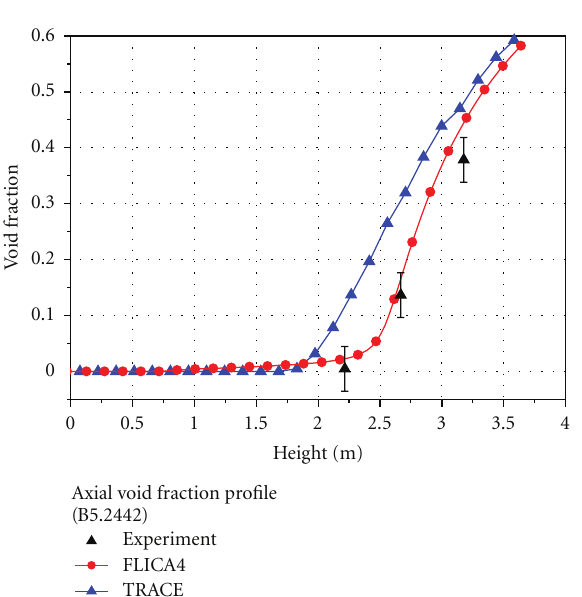
Figure 15: Axial void fraction profile of case B5.2442.